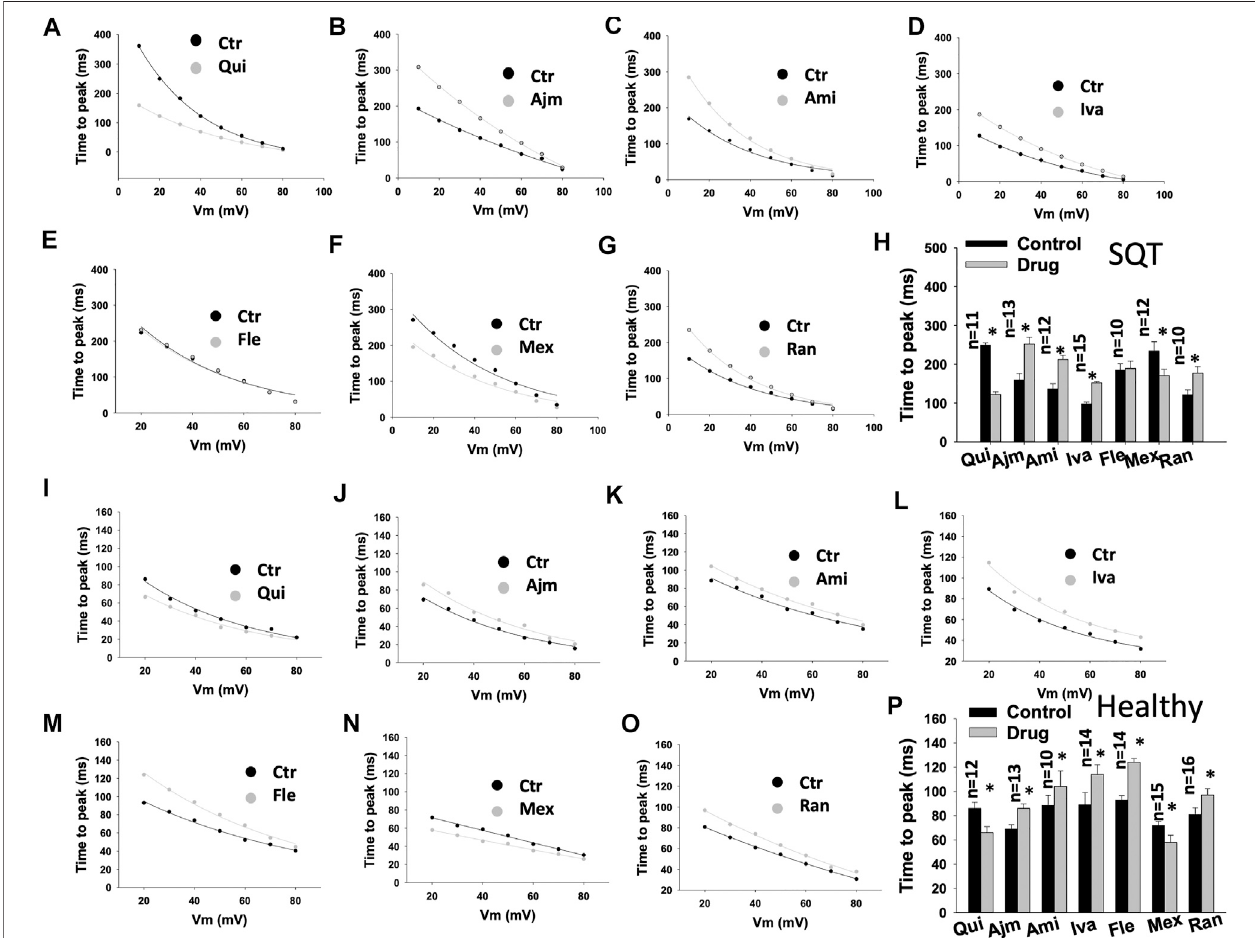
FIGURE2| DrugeffectsonthetimetopeakofI Kr inSQTS1-hiPSC-CMs.Thetimetopeak(thetimebetweenthestartofapulsetothehighestpeakcurrentpoint)of I Kr was measured in current traces from 10 to 80 mV and plotted against voltages. The same cells before and after application of a drug were measured. (A – G) Representative curves of time to peak in SQT1-hiPSC-CMs in absence (Ctr) and presence of quinidine (Qui, 10 µM), ajmaline (Ajm, 30 µM), amiodarone (Ami, 10 µM), ivabradine (Iva, 10 µM), fl ecainide (Fle, 30 µM), mexiletine (Mex, 100 µM) and ranolazine (Ran, 30 µM). (H) Averaged values of time to peak at 20 mV in SQT1- hiPSC-CMs in absence (Ctr) and presence of drugs. (I – O) Representative curves of time to peak in donor-hiPSC-CMs in absence (Ctr) and presence of quinidine (Qui, 10 µM), ajmaline (Ajm, 30 µM), amiodarone (Ami, 10 µM), ivabradine (Iva, 10 µM), fl ecainide (Fle, 30 µM), mexiletine (Mex, 100 µM) and ranolazine (Ran, 30 µM). (P) Averaged values of time to peak at 20 mV in donor-hiPSC-CMs in absence (Ctr) and presence of drugs. Shown are mean ± SEM, n represents number of cells. The statistical signi fi cance was examined by paired t-test, * p < 0.05 versus Control.